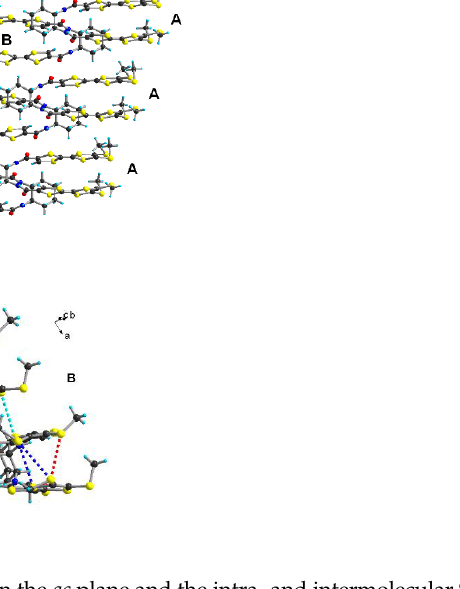
Figure 5. Asymmetric unit structure of ( rac )- 1 ( a ) and top view of molecule A ( b ). In the crystal, the asymmetric unit ( AB ) forms columns along the a -axis, which alter- nate along the c -axis (Figure 6). Within the stack, molecules show a short S ··· S interaction of 4.01 Å for molecules A, and 3.72 Å for molecules B (turquoise dotted line), and of 3.86 – 4.06 Å between the A and B molecules (orange dotted lines). The pincer-like framework of the TTF units of each molecule is due to the S ··· S interactions of 3.81 – 3.98 Å (blue dotted lines) and of 3.38 Å for molecules A and 3.51 Å for molecules B (red dotted lines).